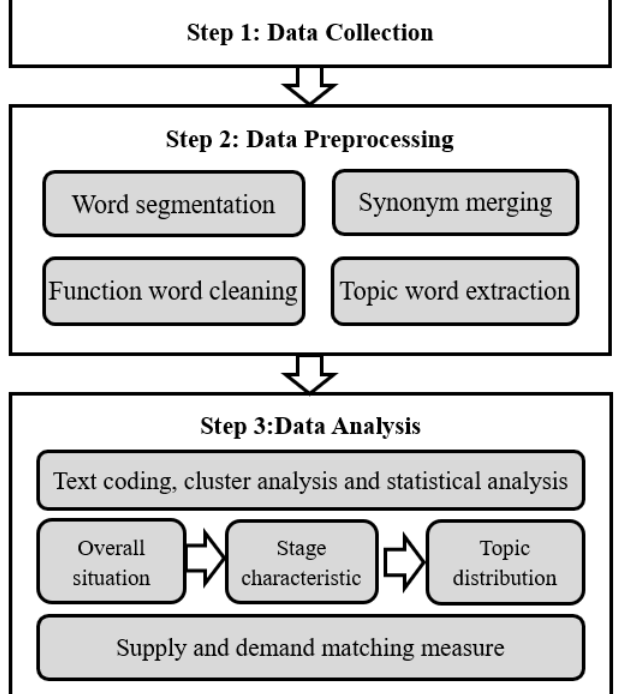
Figure 1. Methodological framework.